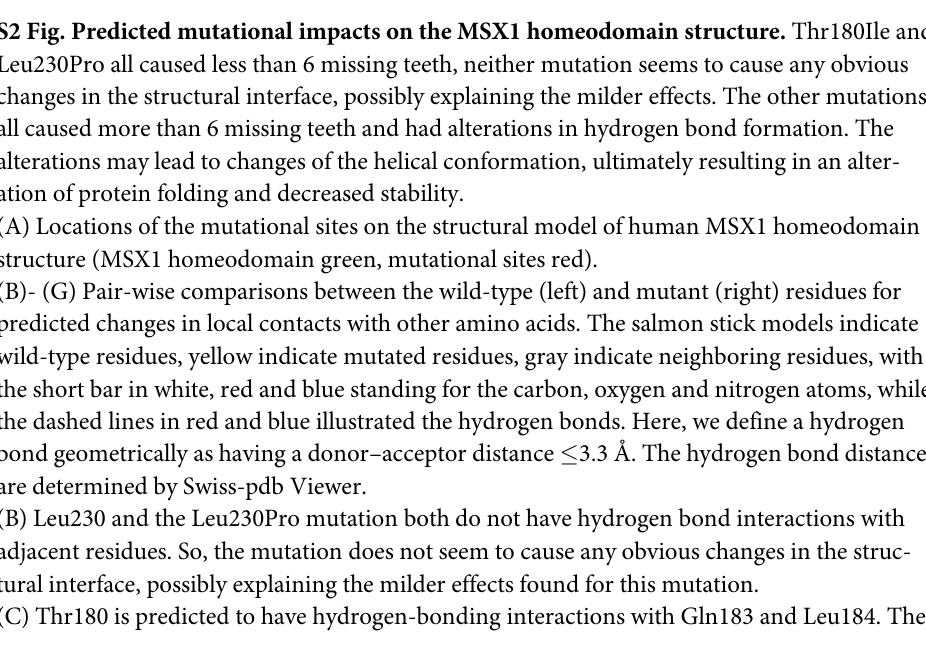
S1 Fig. Comparison of wild type and c. 590_594 dup TGTCC protein sequences of